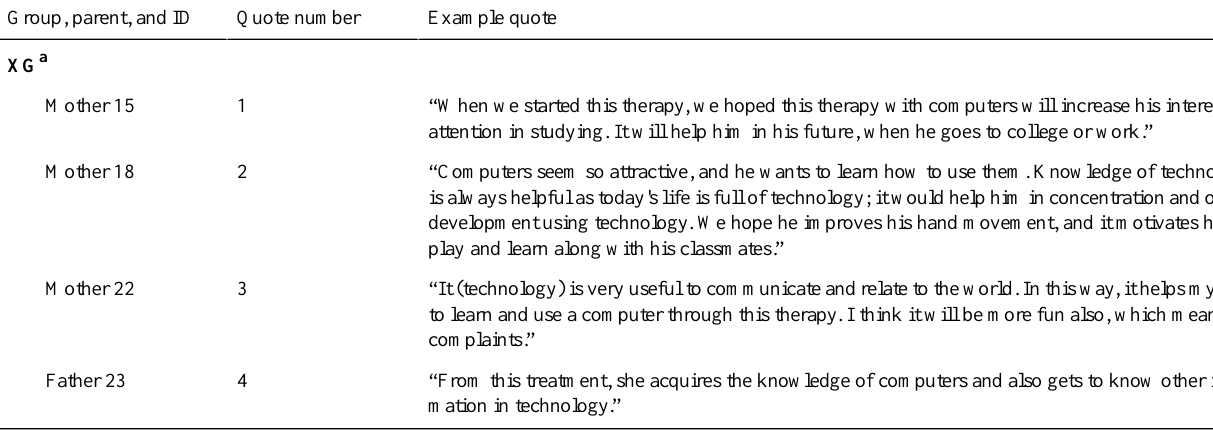
Table 3. Parents’responses about the use of